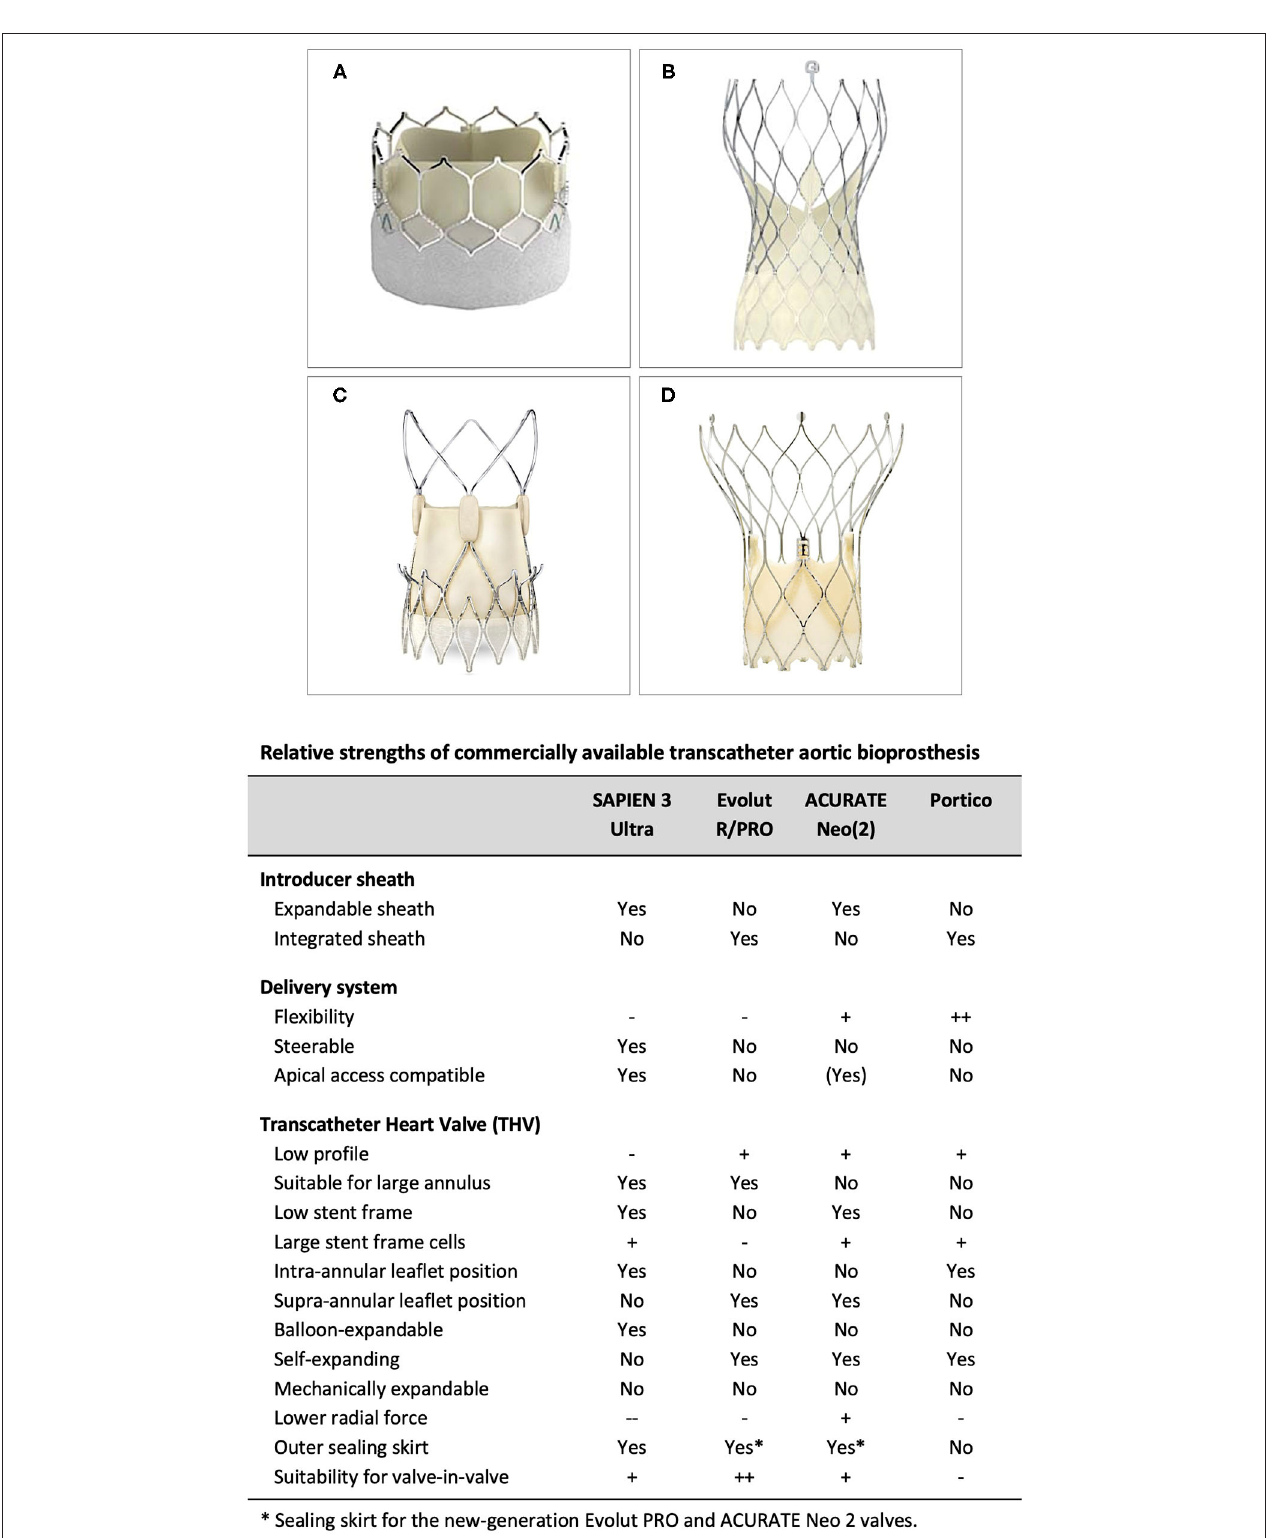
FIGURE 3 | Relative strengths of commercially available transcatheter aortic bioprosthesis. (A) SAPIEN 3 (Ultra), (B) Evolut R/PRO, (C) ACURATE Neo (2), and (D) Portico TAVI System.